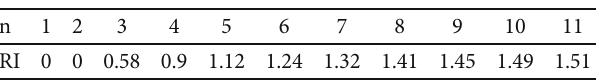
Table 3: Randomness index values [35].